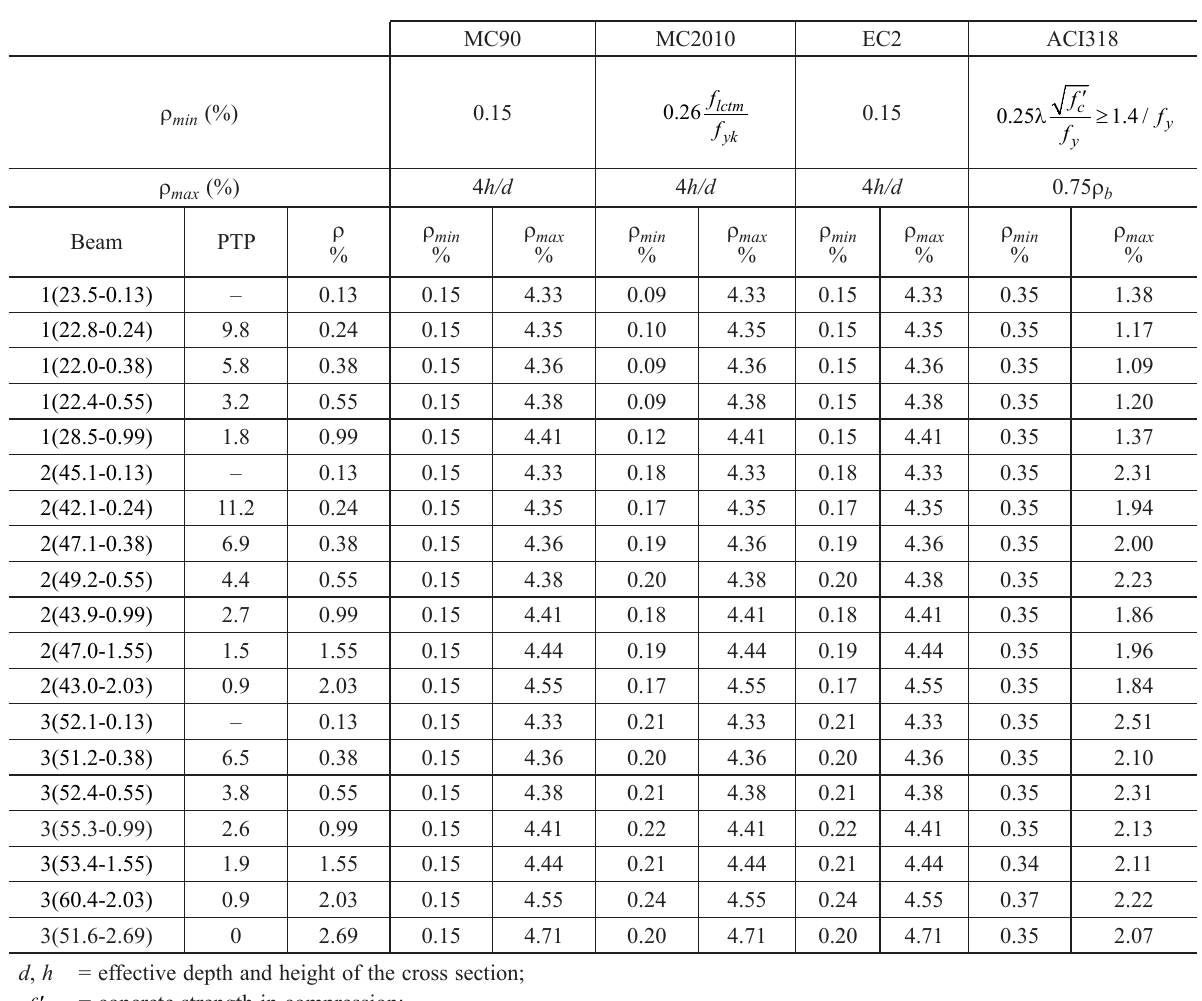
Table 4. Limits for the tensile reinforcement ratios